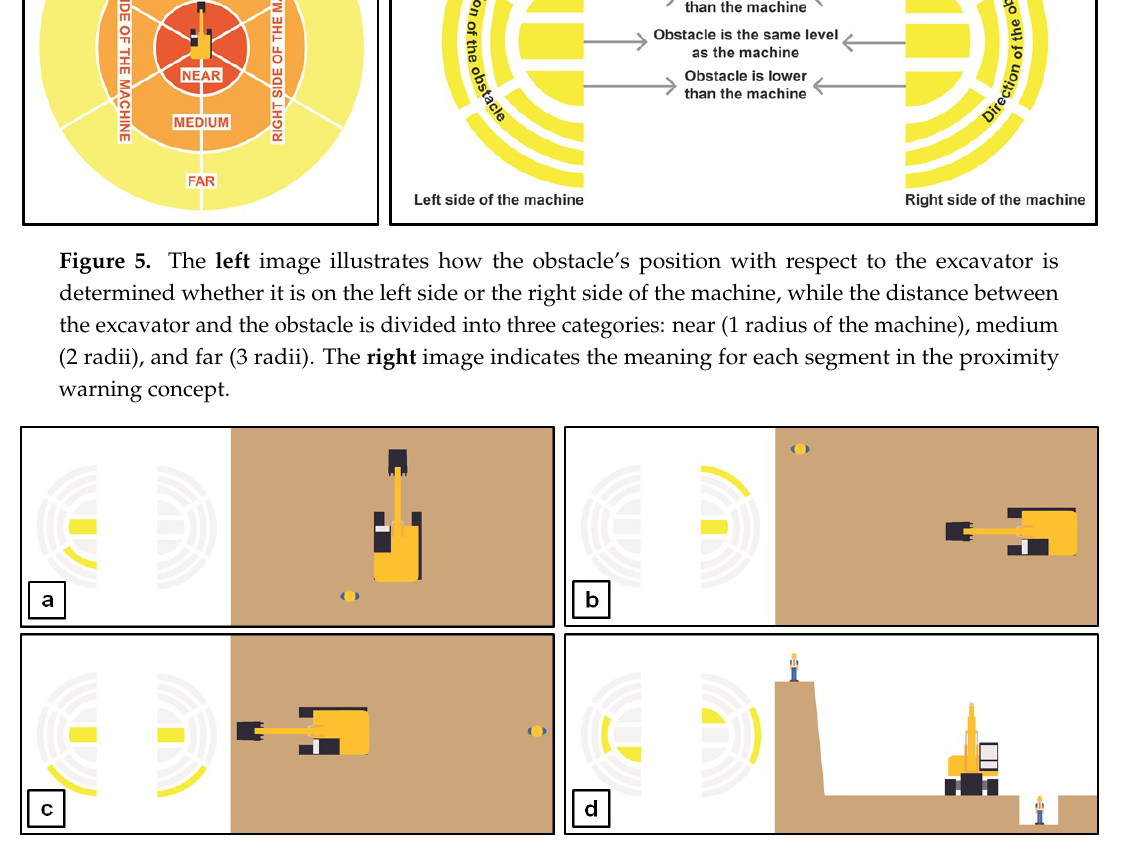
Figure 6. The images that illustrate how the proximity warning concept would change based on the position of the obstacle(s). ( a ) There is an obstacle near rear left of the machine. ( b ) There is a far obstacle in front right of the machine. ( c ) There is a far obstacle exactly behind the machine. As the visualization is split into left and right sides, the same segments on both sides are illuminated when there is an obstacle exactly in front of or behind the machine. ( d ) There are two obstacles with different altitudes. One obstacle is on the left side, near, and lower than the machine, while the other one is on the right side, far, and higher than the